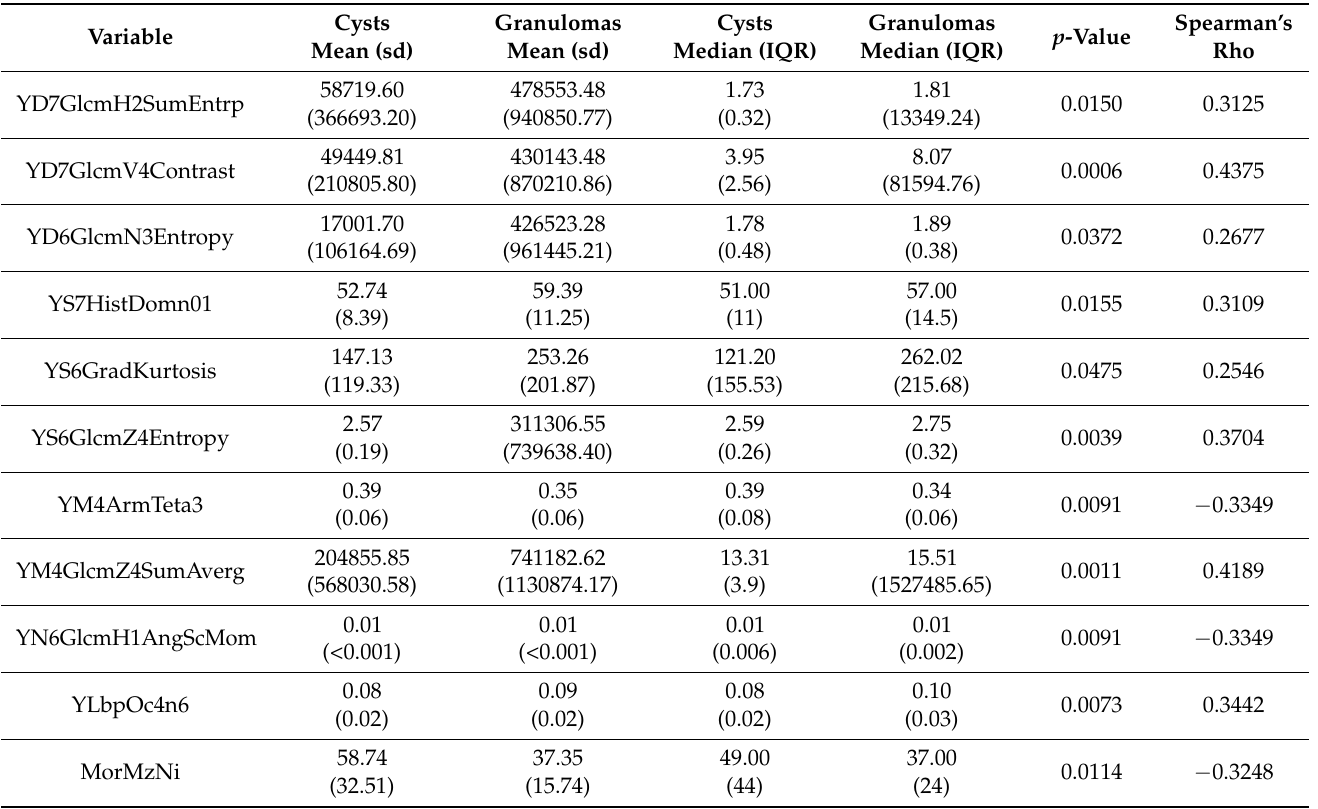
Table 1. The potential input variables for a target variable identified using statistically based methods.